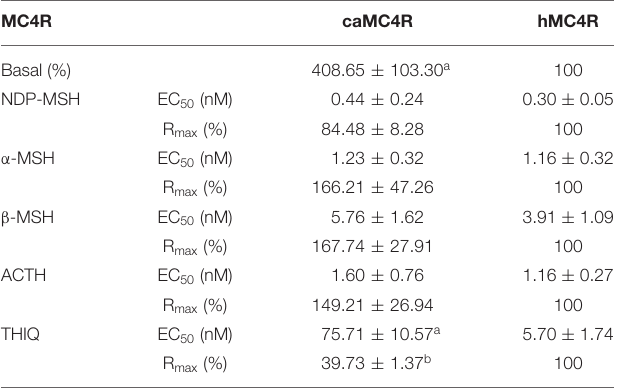
TABLE 2 | The signaling properties of hMC4R and